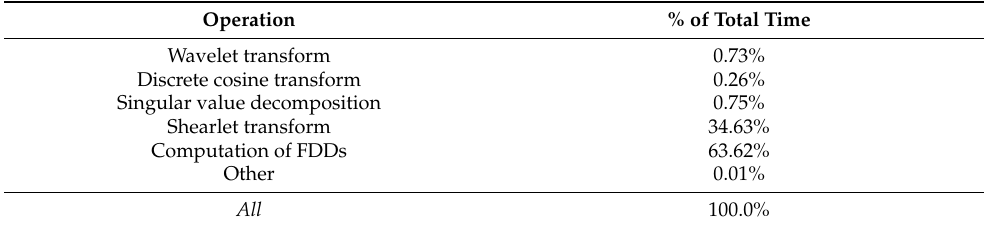
Table 15. Profile summary of FDD-IQA measured on KonIQ-10k [21]. It presents statistics about the overall execution and a representation of the time spent in different modules of FDD-IQA .